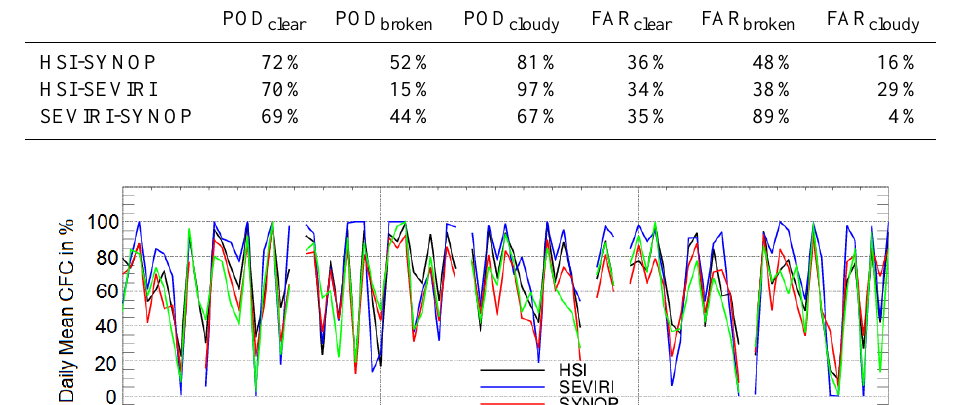
Table 5. Table of all results of the comparisons between instantaneous SEVIRI, SYNOP and HSI CFC in Hannover, Germany. The results are presented as POD clear , POD broken , POD cloudy , FAR clear , FAR broken and FAR cloudy (clear: cloud-free, broken: cloud-contaminated, cloudy: cloud-covered).